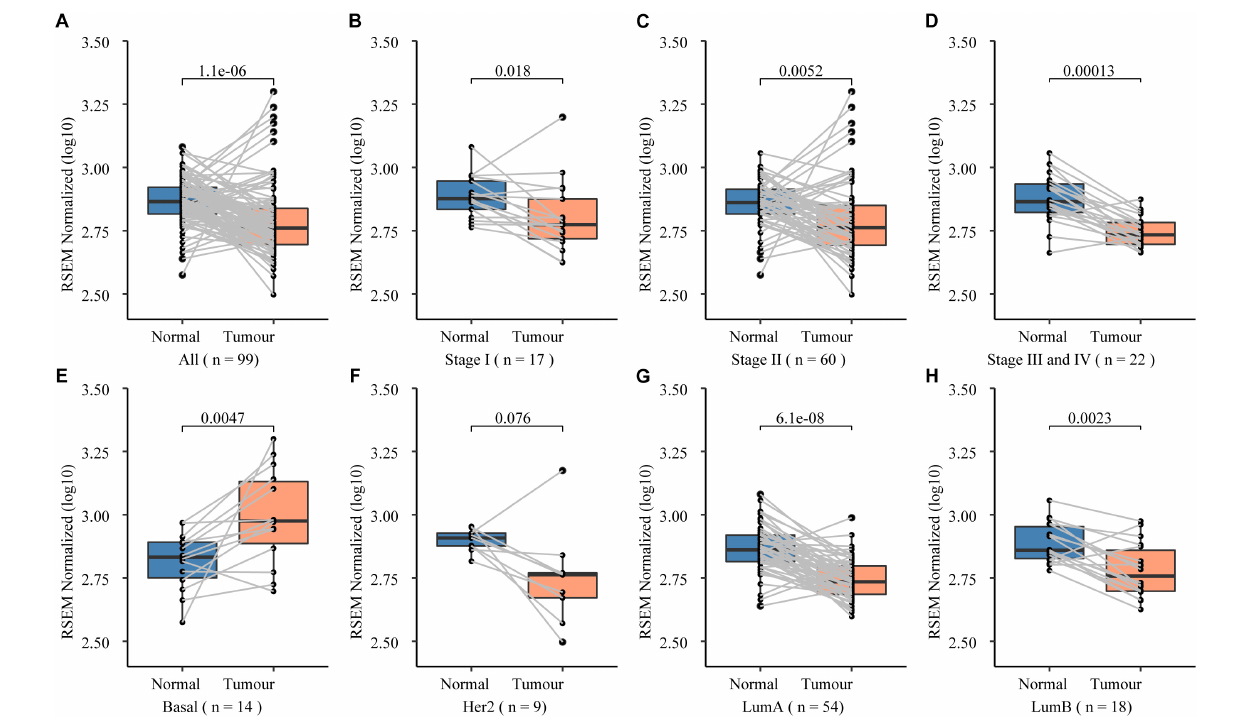
FIGURE 2 | Expression spectrum of NCK1 in 99 tumor-normal paired samples across different stage and subtypes. (A) All; (B) Stage I; (C) Stage II; (D) Stage III and IV; (E) basal-like; (F) Her2; (G) LumA (LuminalA); and (H) LumB (LuminalB).